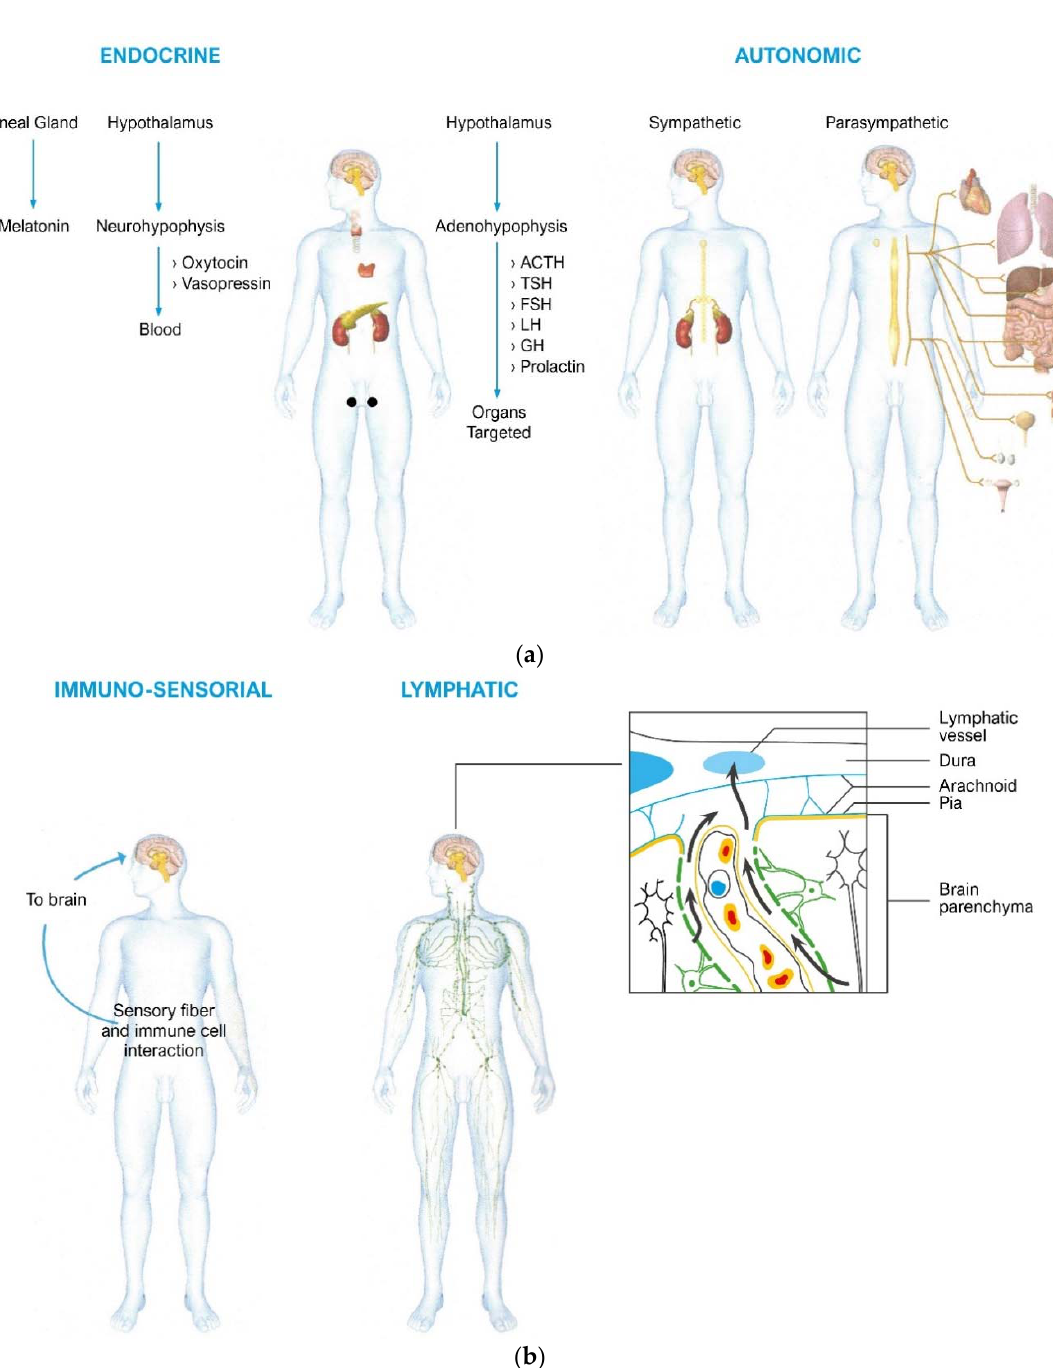
Figure 1. ( a , b ). The complex neuroendocrineimmune network. In ( a ), the endocrine pathways are indicated: the pineal gland that produces melatonin with effects of regulation of the circadian rhythms and also of the immune system (not shown); the hypothalamus which activates the neuroendocrine axes, including the stress axis; and the autonomic nervous system that influences organs and tissues with the sympathetic and parasympathetic arms. In ( b ), the sensory nervous system and immune cells communicate with each other and with the brain through the release of cytokines and neuropeptides; the figure also indicates the lymphatic connection which, contrary to a centennial dogma that considered the brain without lymphatic vessels, connects the brain to the general lymphatic system and, therefore, to the immune system organized in the lymph nodes. To integrate the network picture, Figure 2 describes the steps that, via a harmful stim ‐ ulus affecting the skin, determine the simultaneous activation of the sensory nervous fiber and immune cells (dendritic and mastoid cells). Nociceptive sensory neurons are activated